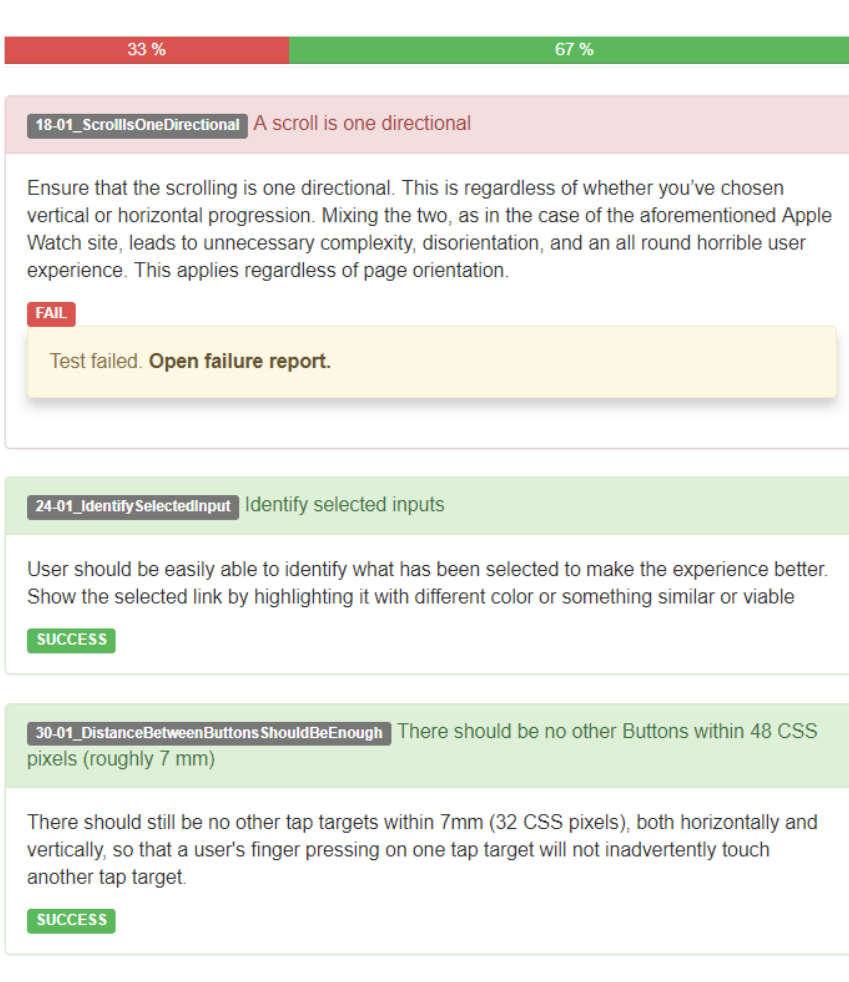
Figure 7. Screenshot of the view containing usability evaluation